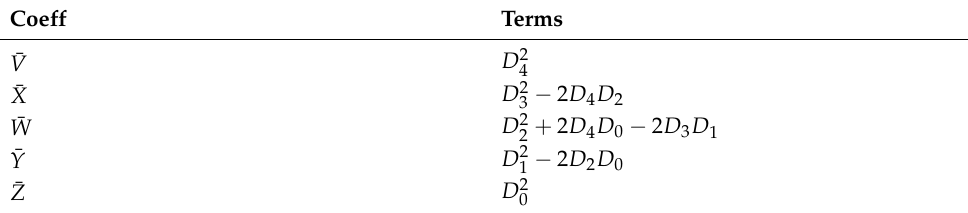
Table 3. Numerator optimisation